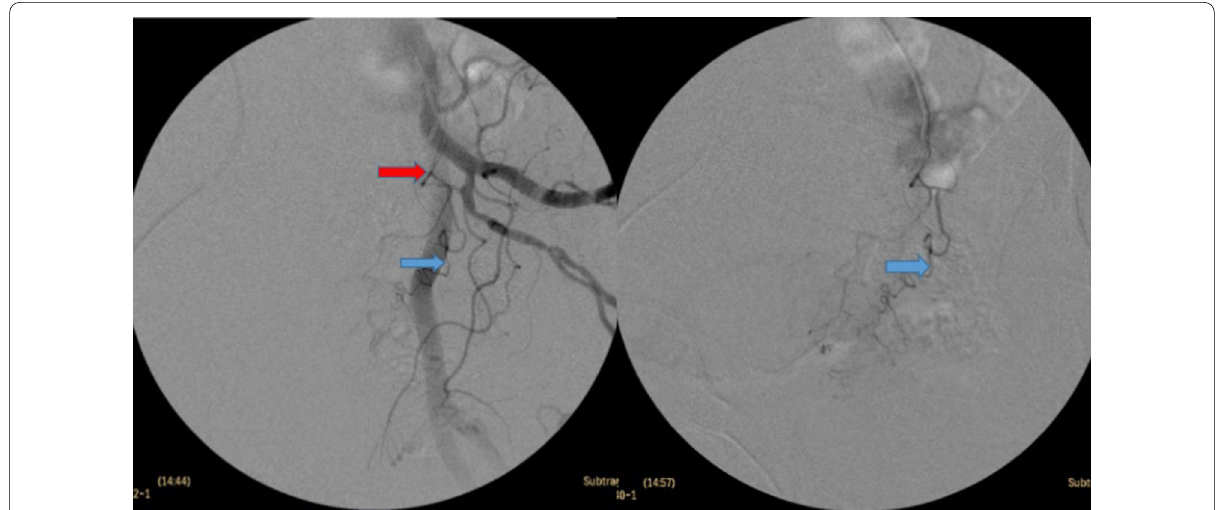
Fig. 11 Angiography images showing the origin of left prostatic artery (blue arrow) with common origin with superior vesical artery (type I) origin